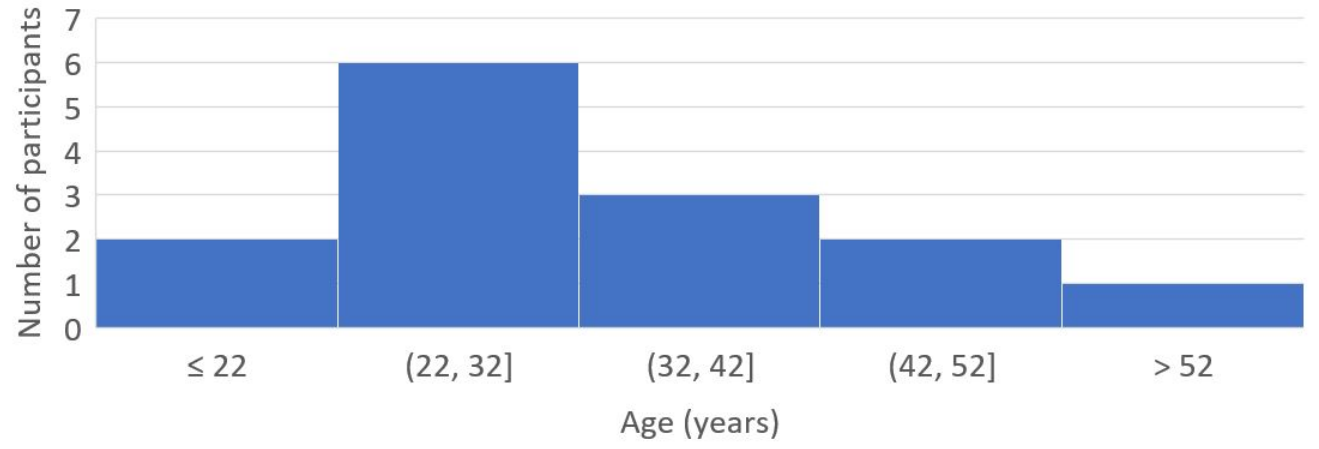
Figure 8. Participants’ age distribution. Table 4. Test subjects performance, unassisted grasping.